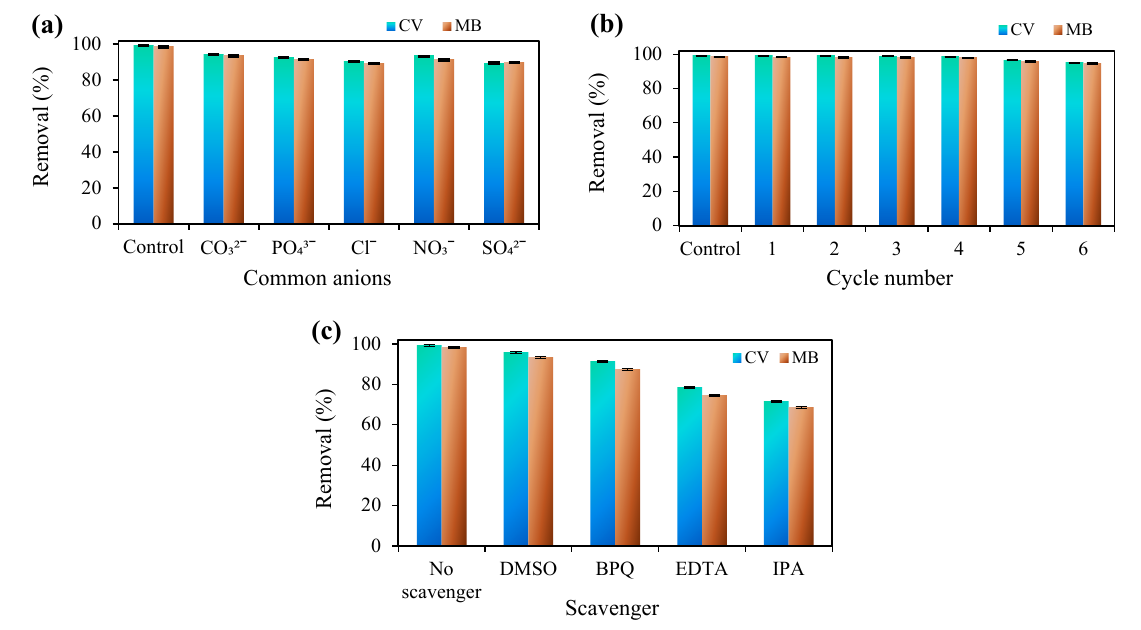
Figure 8. ( a ) The effect of common anions on the efficiency of the dye degradation using the sono- photocatalytic process, ( b ) the ability to reuse the Cloisite 30B/ZnO/Ag 2 O catalyst in the degradation of dyes and ( c ) the effect of different scavengers on the efficiency of the dyes degradation (dye con- centration: 5 mg/L, catalyst dose: 0.5 g/L, reaction time: 50 min, amount of H 2 O 2 : 40 mM/100 mL, and pH = 8).